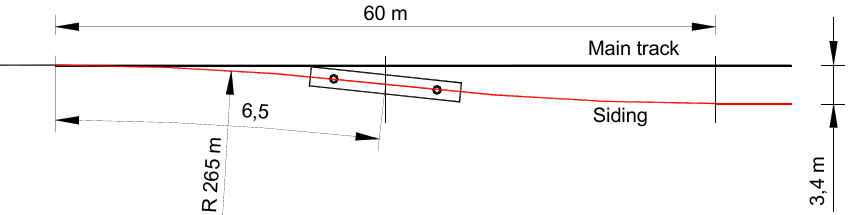
Figure 1. Simplified geometry of a siding switch able to divert a train from the main track in black (H0) and siding track in red (H1).